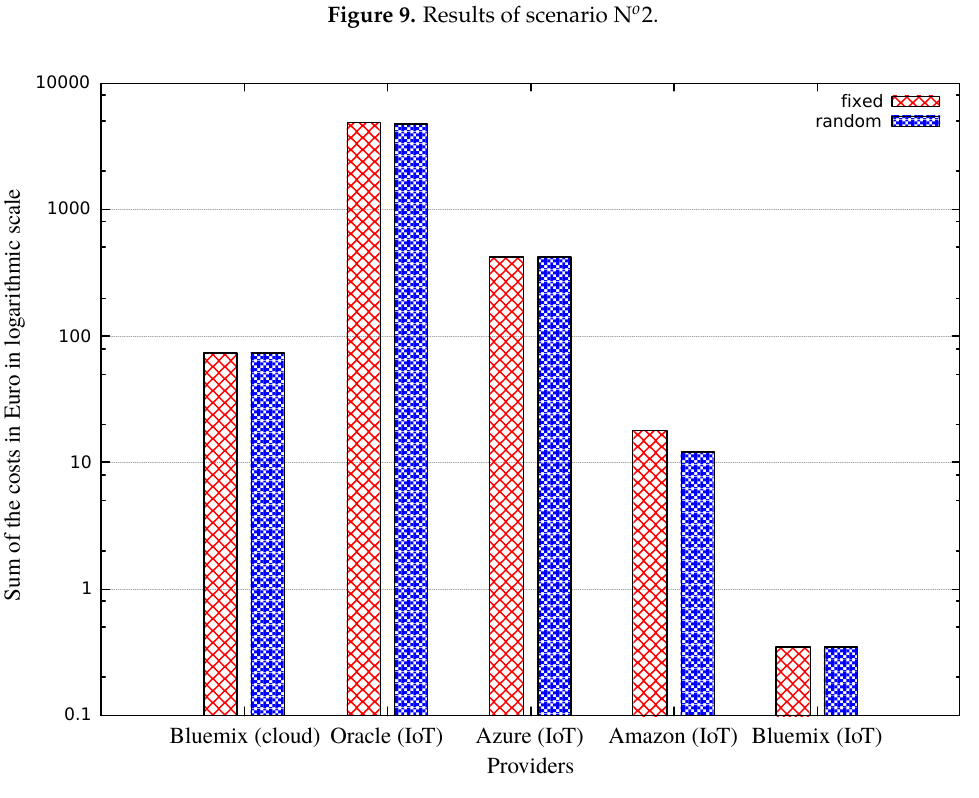
Figure 10. Cost of the providers in scenario N o